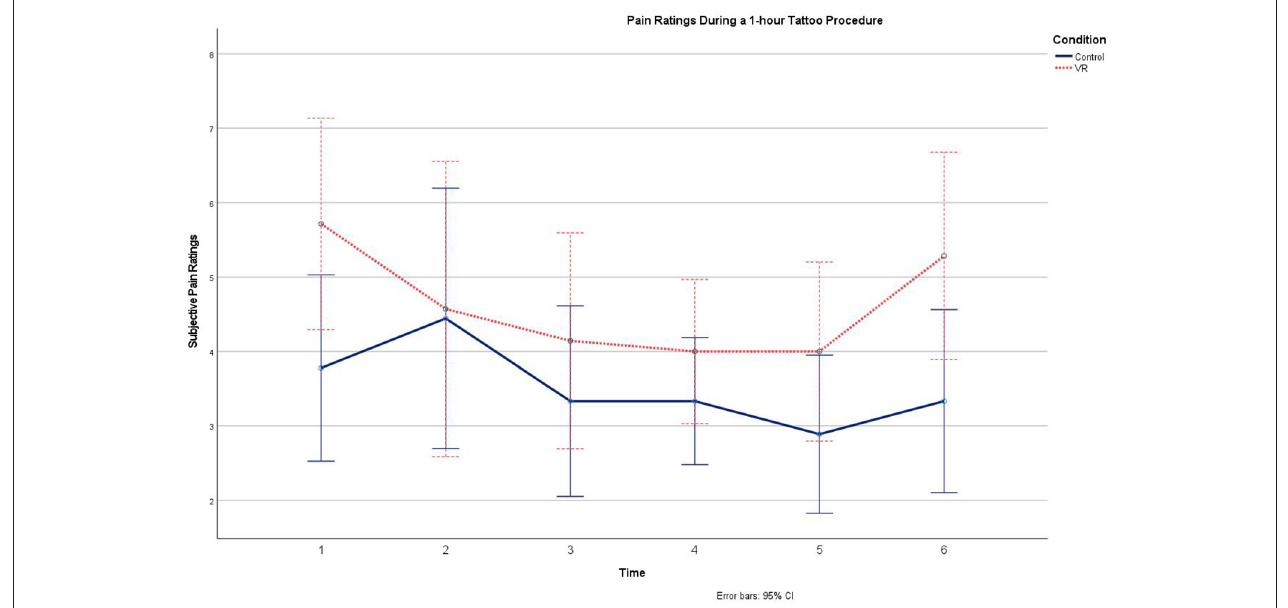
FIGURE 4 | Graph demonstrating the interaction effect between time and contextual responsiveness on copresence with a VH.